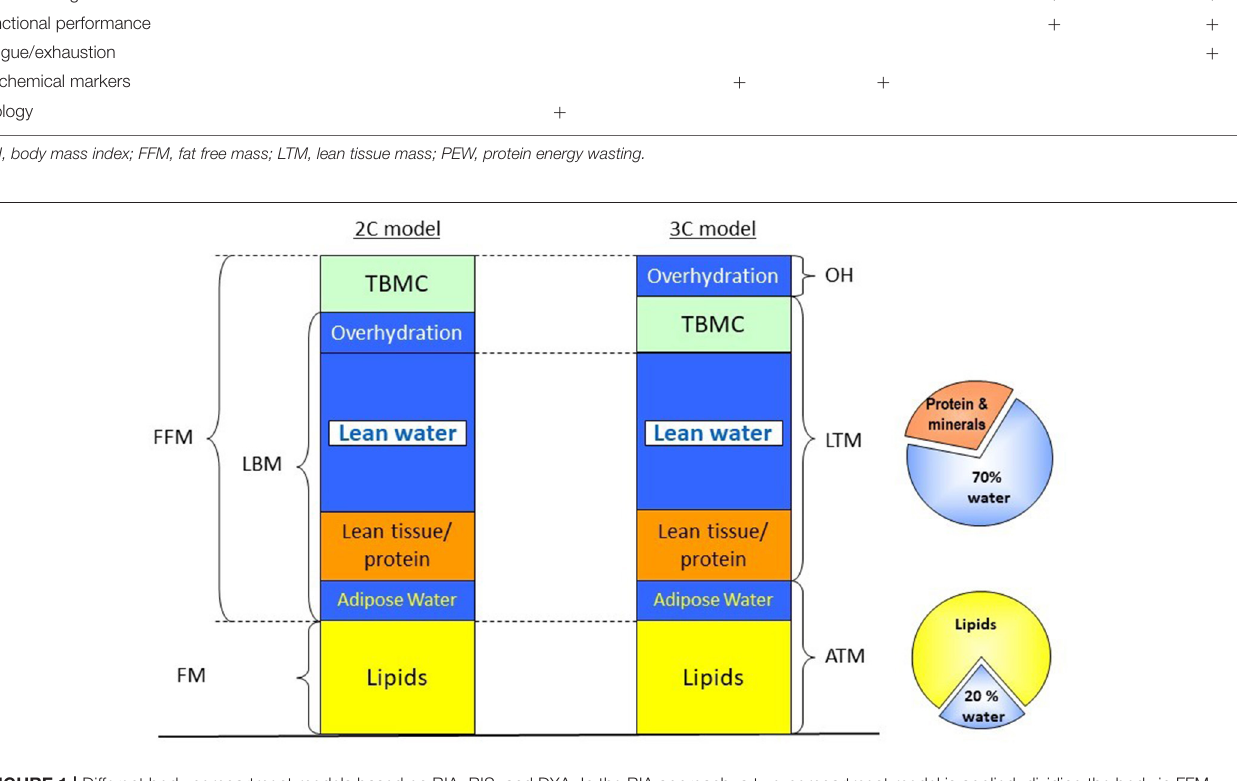
FIGURE 1 | Different body compartment models based on BIA, BIS, and DXA. In the BIA approach, a two-compartment model is applied, dividing the body in FFM, which includes bone mineral tissue, total body water, skeletal muscle and visceral proteins, and FM. Both DXA and three-compartment BIS apply a three-compartment approach; however, in the case of DXA, bone mineral density is removed from the FFM, and LBM is measured instead, while in the case of BIS, a virtual “overhydration” compartment is calculated as the difference between measured and expected ECW, providing information on ATM and a normohydrate LTM, which includes bone mineral tissue. ATM, adipose tissue mass; BIA, bioelectrical impedance analysis; BIS, bioelectrical impedance spectroscopy; DXA, dual-energy X-ray absorptiometry; FFM, fat-free mass; FM, fat mass; LBM, lean body mass; LTM, lean tissue mass; OH, overhydration; TBMC, total body mineral content. Modified from Broers et al. (22) with